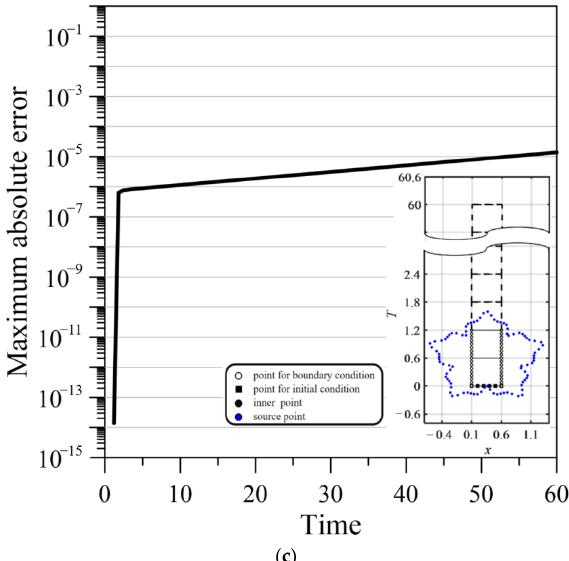
Figure 6. Error comparison of three methods. ( a ) MAE versus simulation time for time marching method. ( b ) MAE versus simulation time for ST method. ( c ) MAE versus simulation time for ST marching method.